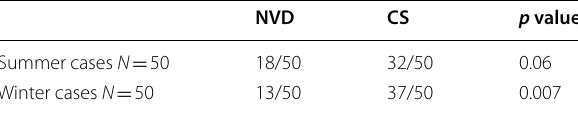
Table 2 Descriptive study of cases regarding the mode of delivery